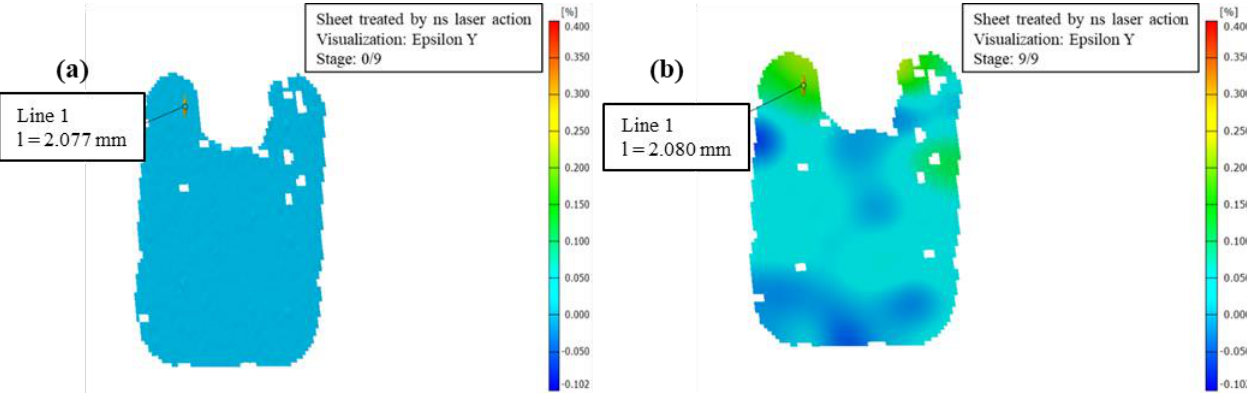
Figure 9. Nimonic 263 sheet, treated by ns laser action DIC measurement 1: ( a ) unloaded state, and ( b ) axial force 5 kN.